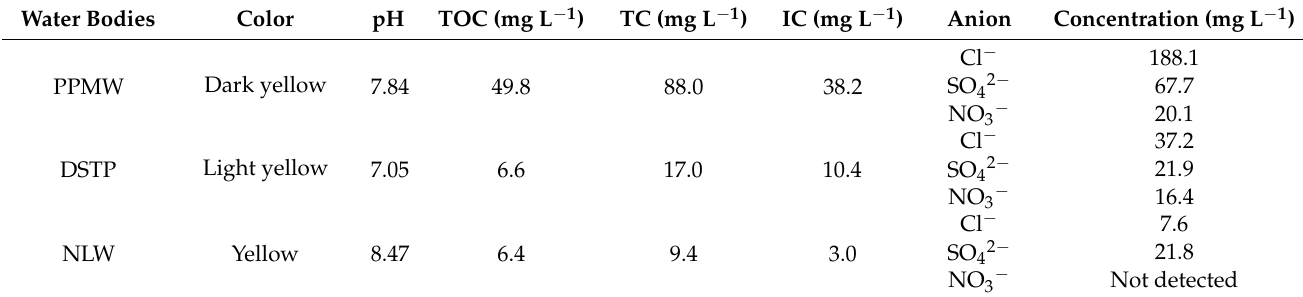
Table 2. Physicochemical parameters and chemical compositions of natural water